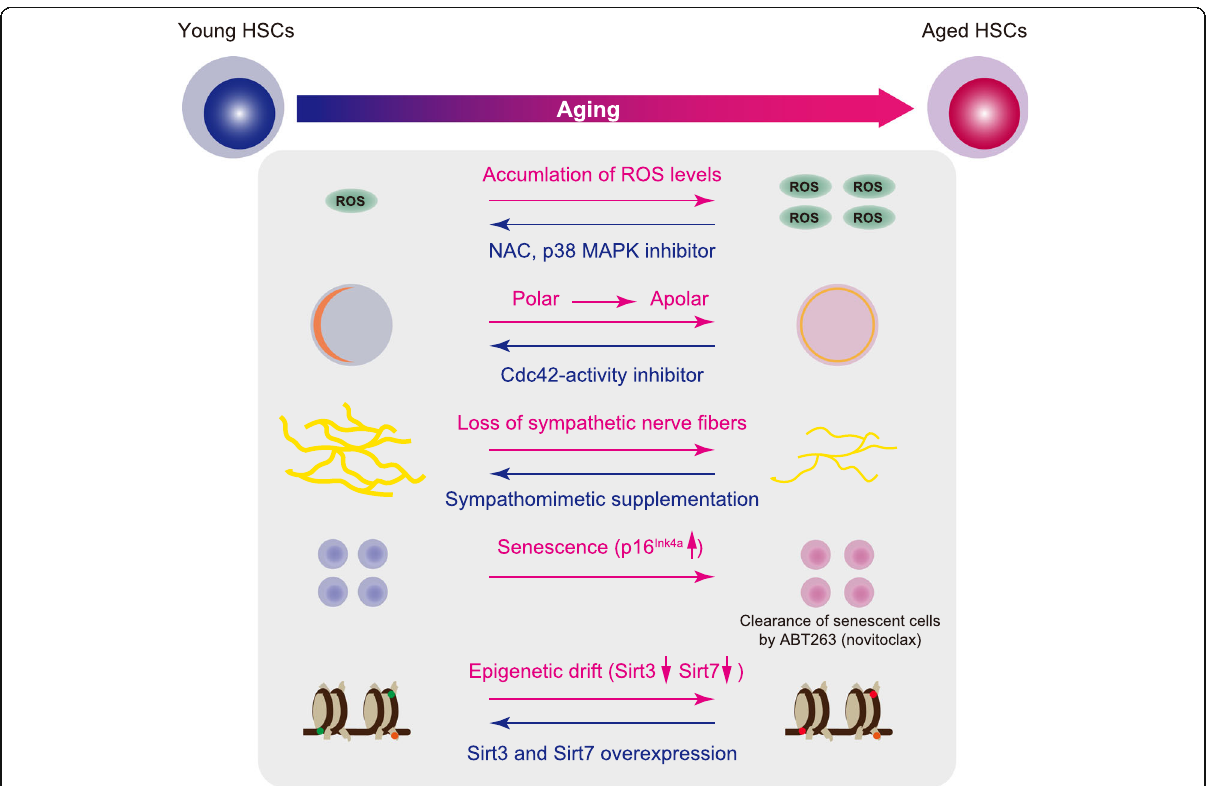
Fig. 1 Factors that promote HSC aging and rejuvenation strategies for aged HSCs. N -acetyl cysteine (NAC) and p38 mitogen-activated protein kinase (MAPK) inhibitor rejuvenate aged hematopoietic stem cells (HSCs) by reducing reactive oxygen species (ROS) levels. Cdc42 activity inhibitor (CASIN) increases the percentage of polarized cells, restores the spatial distribution of H4 at lysine 16 acetylation, increases lymphoid output, and reduces myeloid lineage output. Sirt3 overexpression restores the long-term competitive repopulation ability. Sirt7 overexpression rescues myeloid-biased differentiation. ABT263 (navitoclax), a BCL-2- and BCL-xL-specific inhibitor, selectively kills senescent cells. Supplementation of a sympathomimetic acting selectively on adrenoreceptor β 3 rejuvenates the function of aged HSCs. The red and blue arrows indicate aging and rejuvenation,